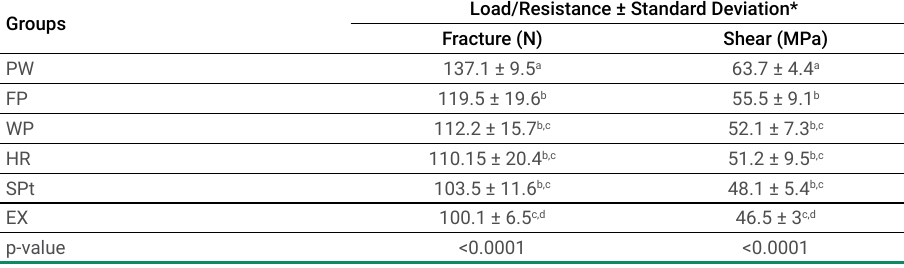
Table 2. Fracture load (N) and shear stress (MPa) of the glass fiber posts. Groups